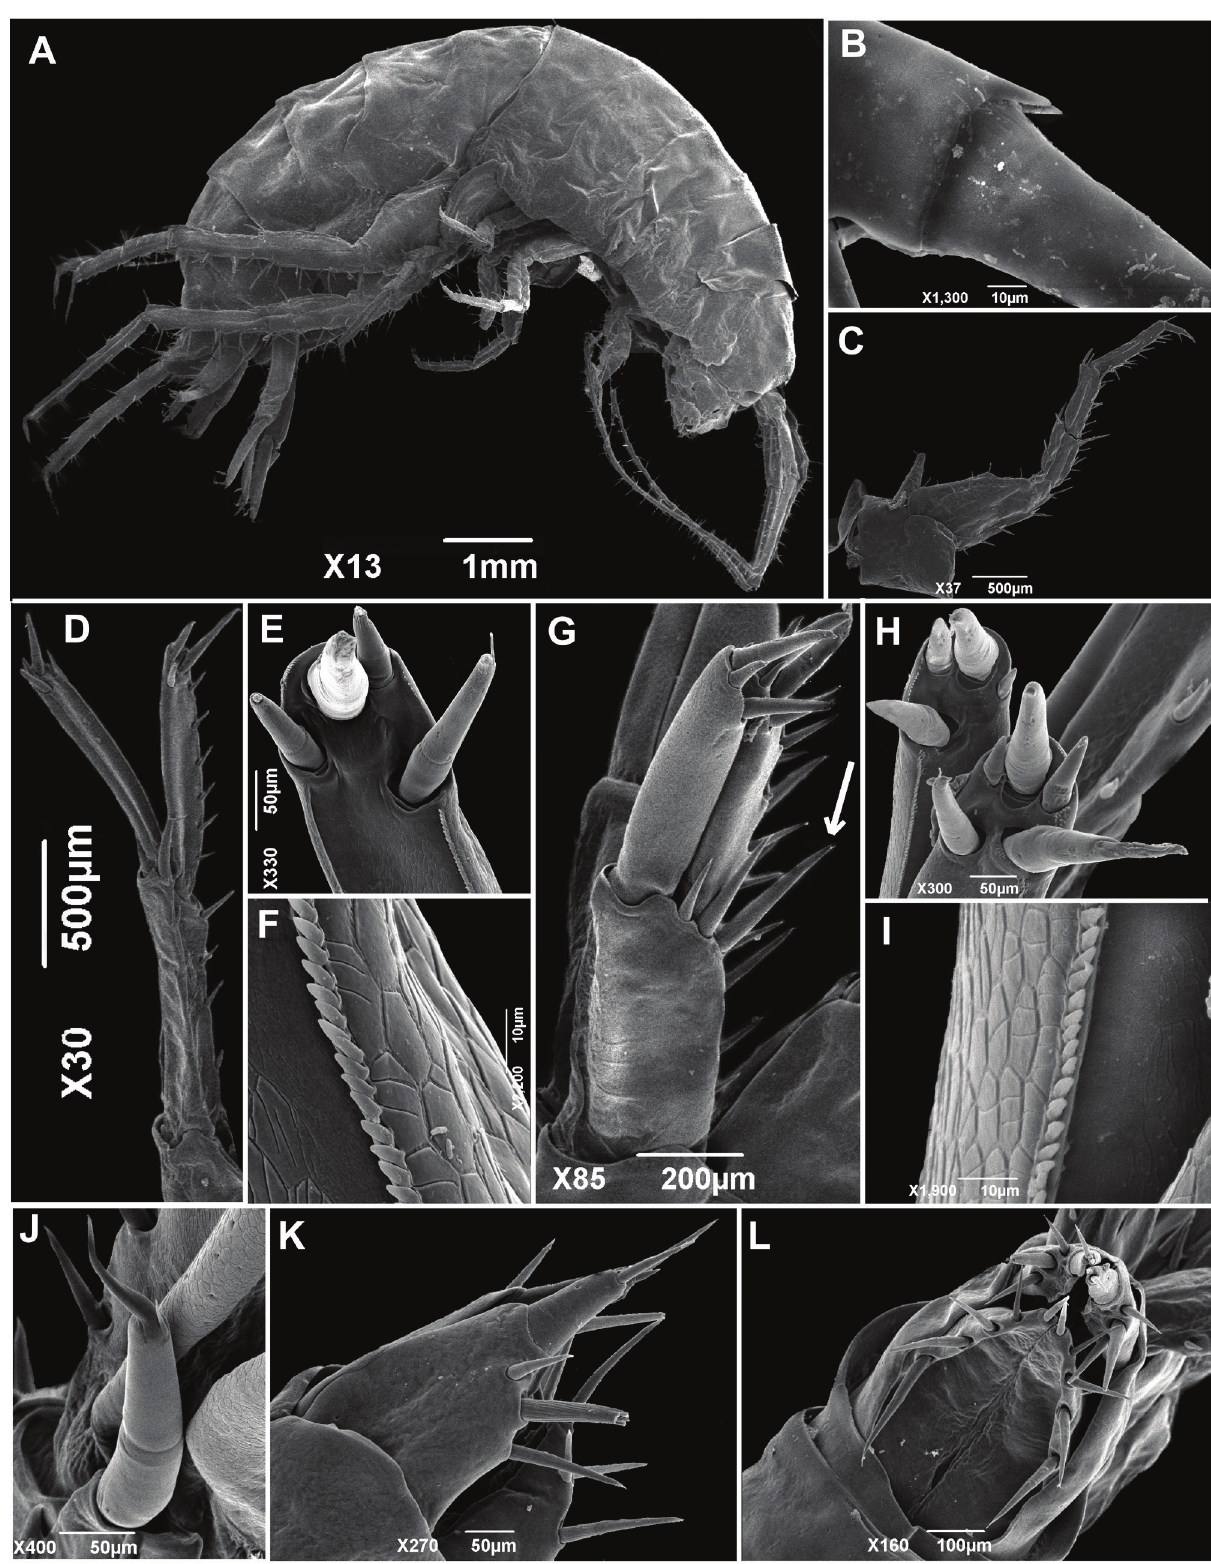
Figure 6. SEM photomicrographs of Talitroides topitotum (Burt, 1934). A) Female MNRJ 14470: Habitus; B – M) Female MNRJ 14470: B) Cuspidactylate dactyl of pereopod 5, C) Pereopod 5, D) Uropod 1, E) Apex of outer ramus of uropod 1, F) Margin of outer ramus of uropod 1, G) Uropod 2 (arrow indicate the larger proximal postero- distal seta), H) Apex of rami of uropod 2, I) Margin of outer ramus of uropod 2, J) Distolateral robust seta in peduncle of uropod 1 with complex apex, K) Uropod 3, L) Telson and uropods